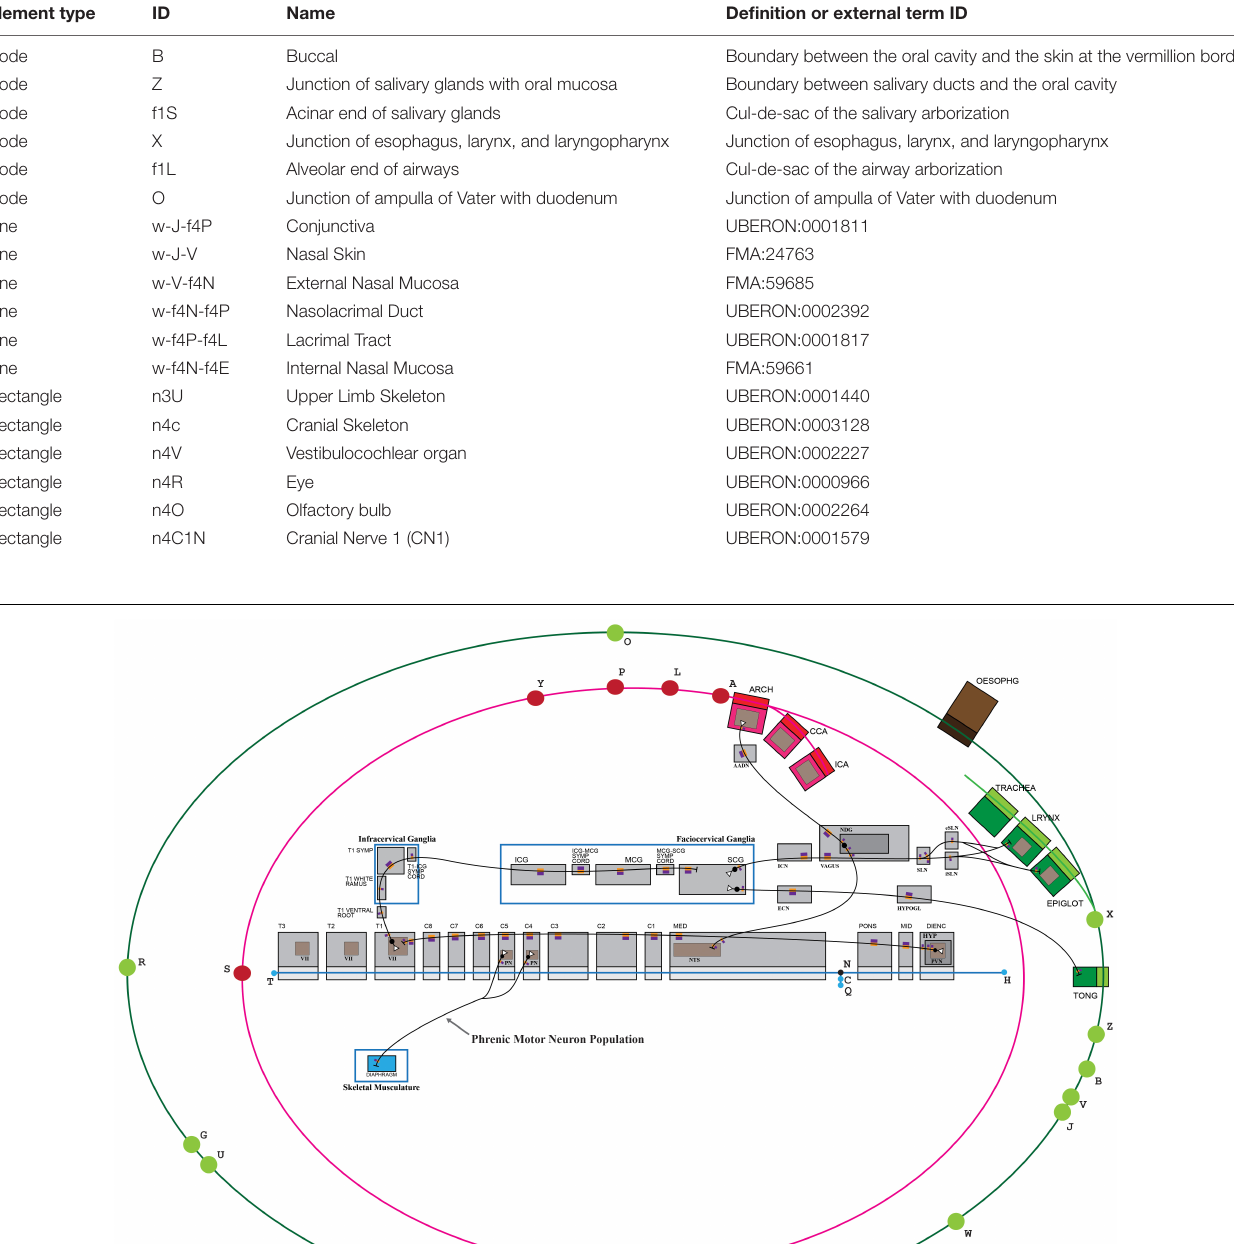
TABLE 2 | Sample definitions of elements that constitute a mammalian TOO map.